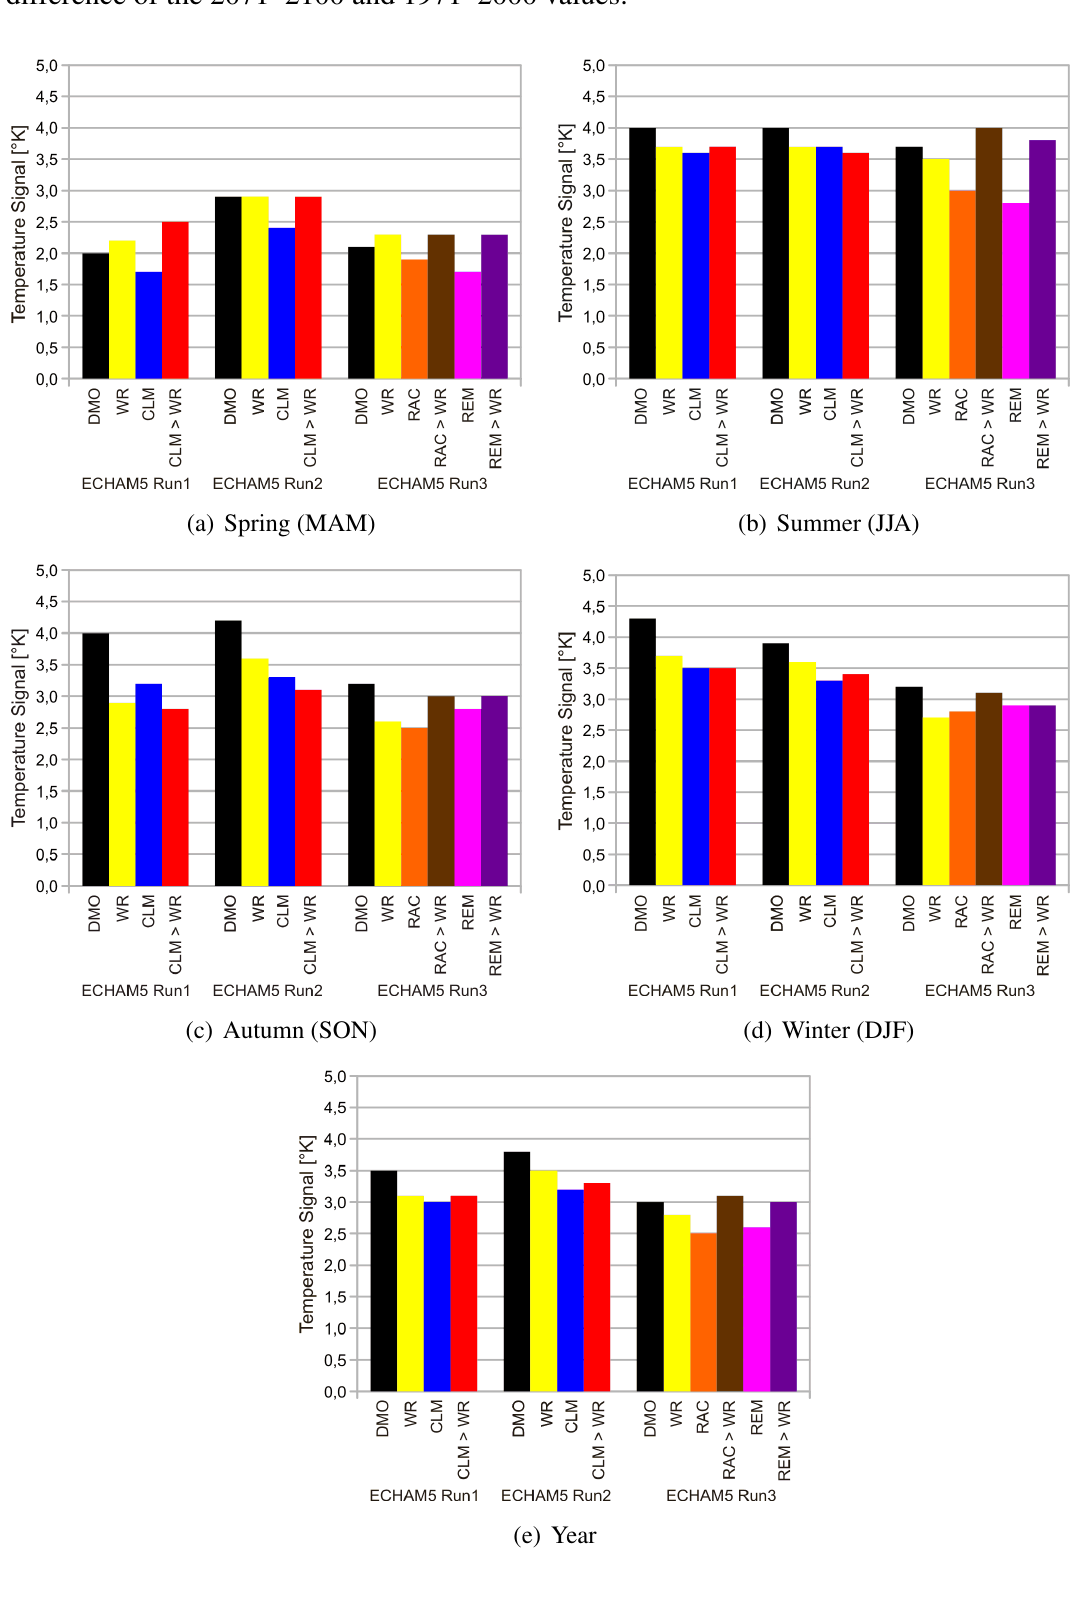
Figure 3. Comparison of the climate signals of 2 m mean temperature, computed as the difference of the 2071–2100 and 1971–2000